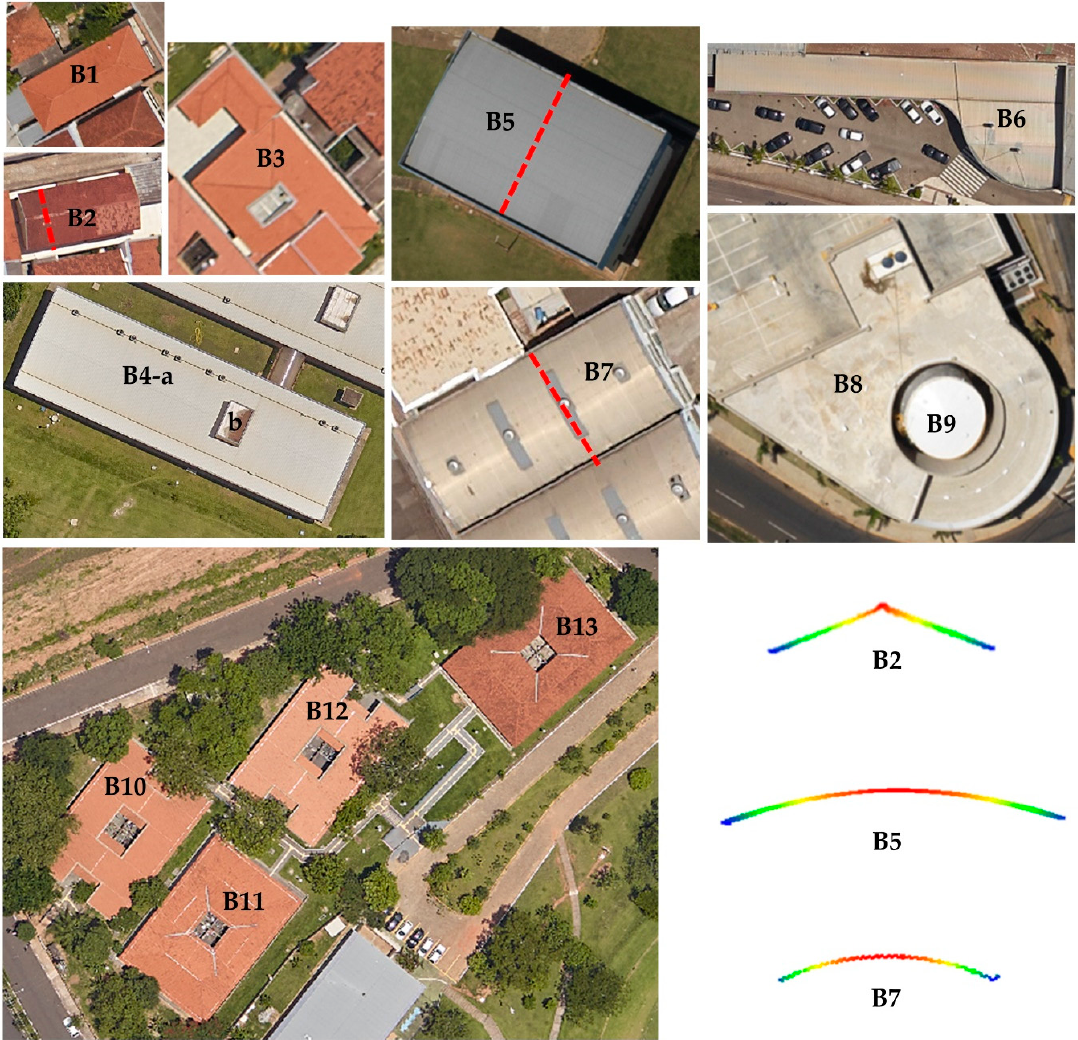
Figure 7. Images of the buildings from Presidente Prudente / Brazil dataset. Buildings selected for the experiments (B1–B13) and the profiles of buildings B2, B5, and B7 generated from LiDAR point cloud.